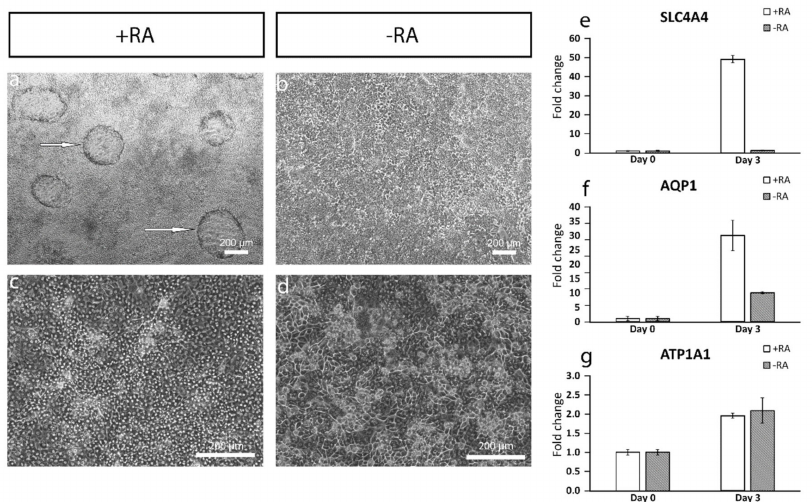
Figure 6. Dome formation was observed already at day 3 of the differentiation. ( a ) White arrows point to the dome structures in the cell culture with RA at day 3. ( b ) Domes are not present in cultures without RA. ( c ) Cells are more polygonal in cell culture with RA at day 10 (RA lowered to 5 µ M for days 3–6 and 0 µ M after day 6) compared to ( d ) cell culture without RA. Expression of RT-qPCR markers of pump-related genes are increased during the differentiation. ( e ) Strong increase can be seen in the expression of sodium bicarbonate cotransporter 1 (SLC4A4) in +RA but not in the − RA. ( f ) Expression of water channel aquaporin 1 (AQP1) is increased in both +RA and − RA but faster in +RA. ( g ) The increase in the expression of pump protein ATPase subunit alpha 1 (ATP1A1) is moderate. Data conducted with ( a , b ) the WT001.TAU.bB2 hiPSC line and ( c – g ) Regea08/017 hESC line. RT-qPCR analyses included three technical replicates. Scale bar ( a – d ) 200 µ